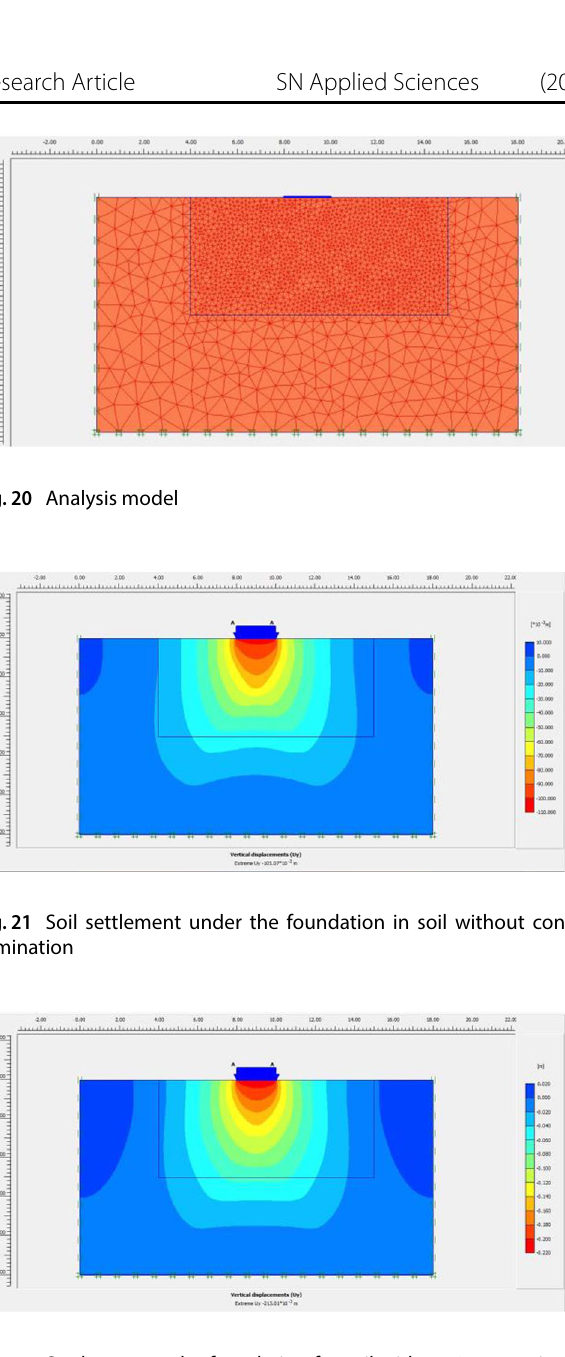
Fig. 22 Settlement under foundation for soil with 12% contamina- tion